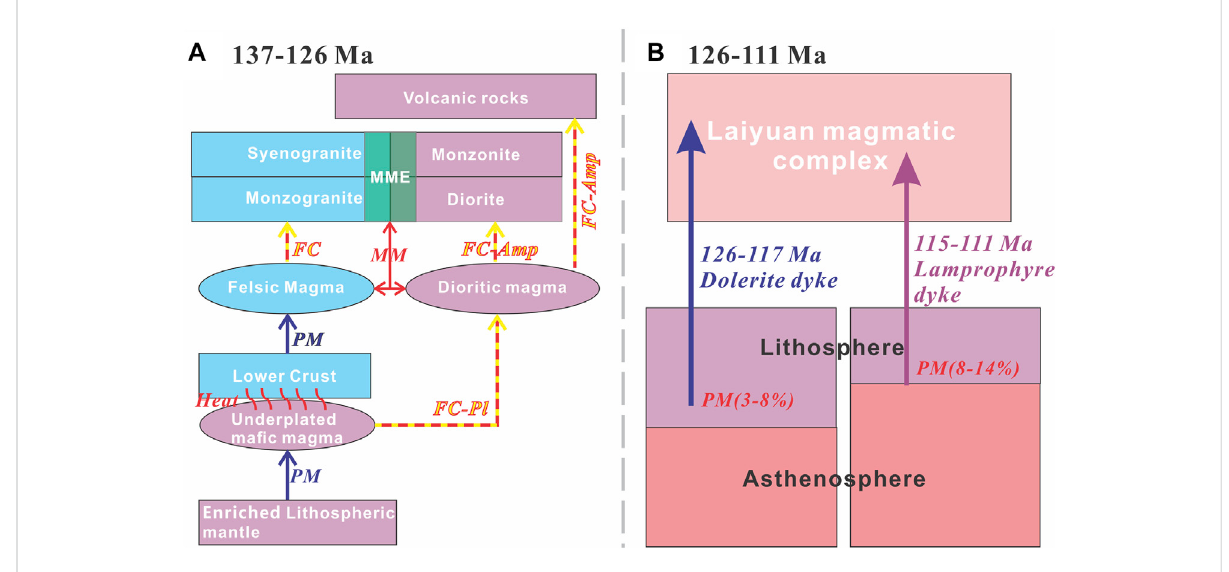
FIGURE 7 Schematic cartoon (not to scale) illustrating the crust-mantle interaction accounting for the formation of Laiyuan granitoid intrusion and Early Cretaceous volcanic rocks from 137 to 126 Ma (A) , and lithosphere-asthenosphere interaction accounting for the generation of dolerite and lamprophyre dyke during 126 – 111 Ma (B) . See context for detailed interpretation. Abbreviations: FC-Amp: amphibole-dominated fractional crystallization; FC-Pl: plagioclase-dominated fractional crystallization; MM: magma mixing; PM: partial melting and the values represent the degrees of partial